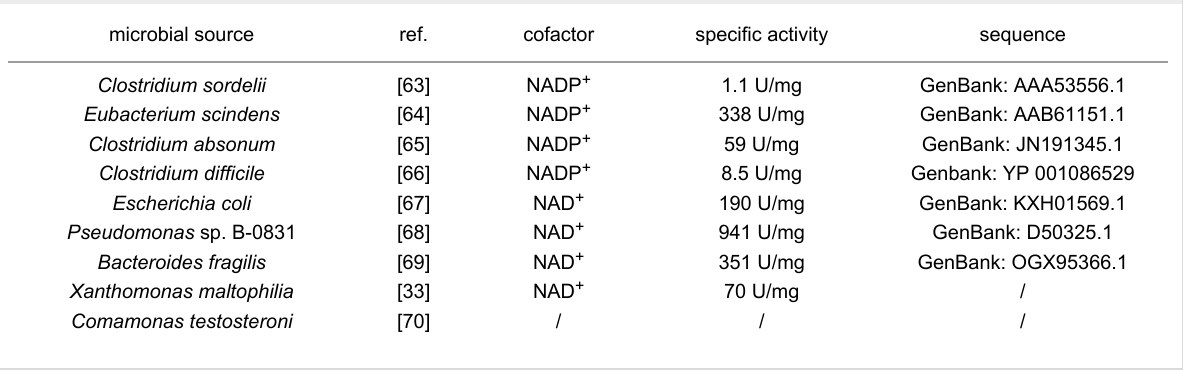
Table 2: Summary of reported 7 α -HSDH. The given activity is on chenodeoxycholic acid as substrate. microbial source